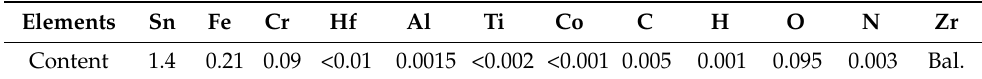
Table 1. Chemical composition of Zr-4